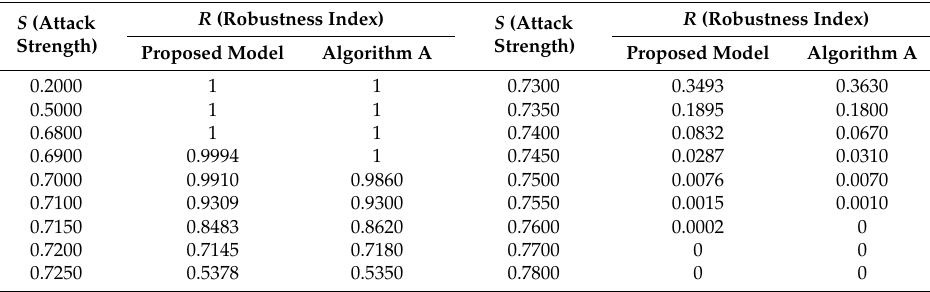
Table 3. Part of robustness results in Experiment